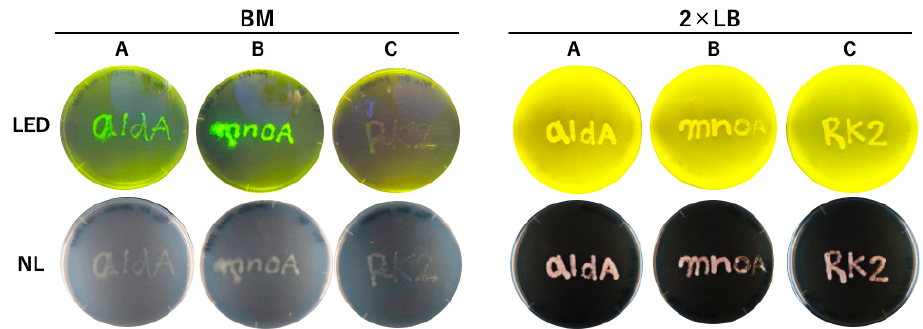
Figure 1. Construction of the reporter strains to examine aldA and mnoA expression. Several characters were drawn on a BM medium by streaking of N9T-4 Δ ligD cells having pAldA-EGFP ( A ), pMnoA-EGFP ( B ), or pNit-RK2 ( C ) and cultivated at 30 °C for 5 days. LED irradiation onto plates excited the fluorescence of EGFP.